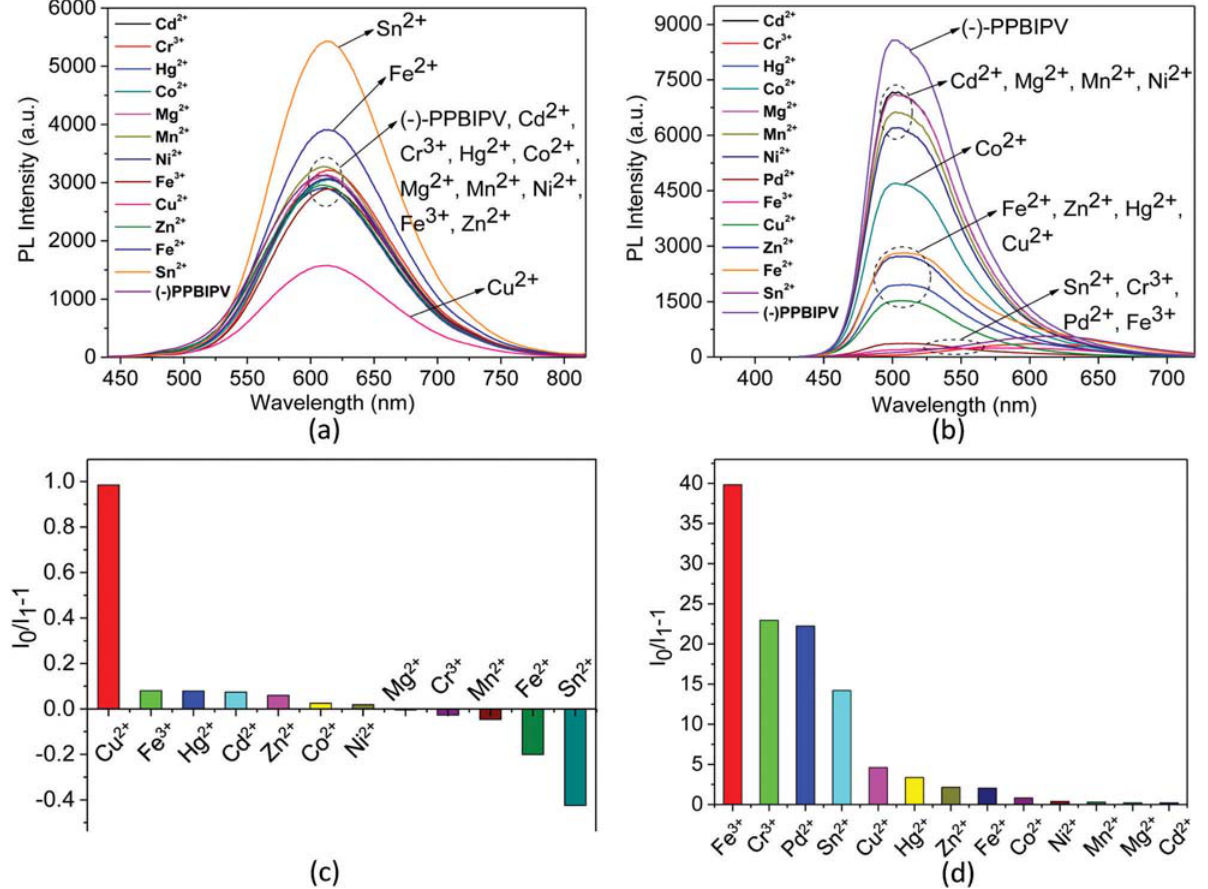
Figure 7: PL spectra of aqueous solution of (-)-PPBIPV with different metal ions (a); PL spectra of methanol solution of (-)-PPBIPV with different metal ions (b); PL quenching ratios (I (I /I -1) of methanol solution of (-)-PPBIPV with different metal ions 0 1